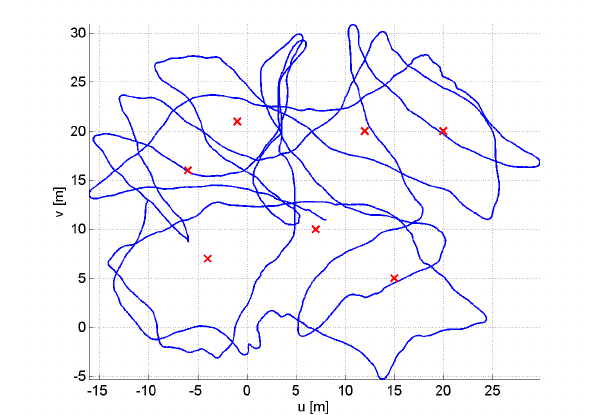
Figure 4: Positions of WiFi stations (red x-marks) on the ( u, v ) plane, and example of simulated UAV trajectory (blue line).